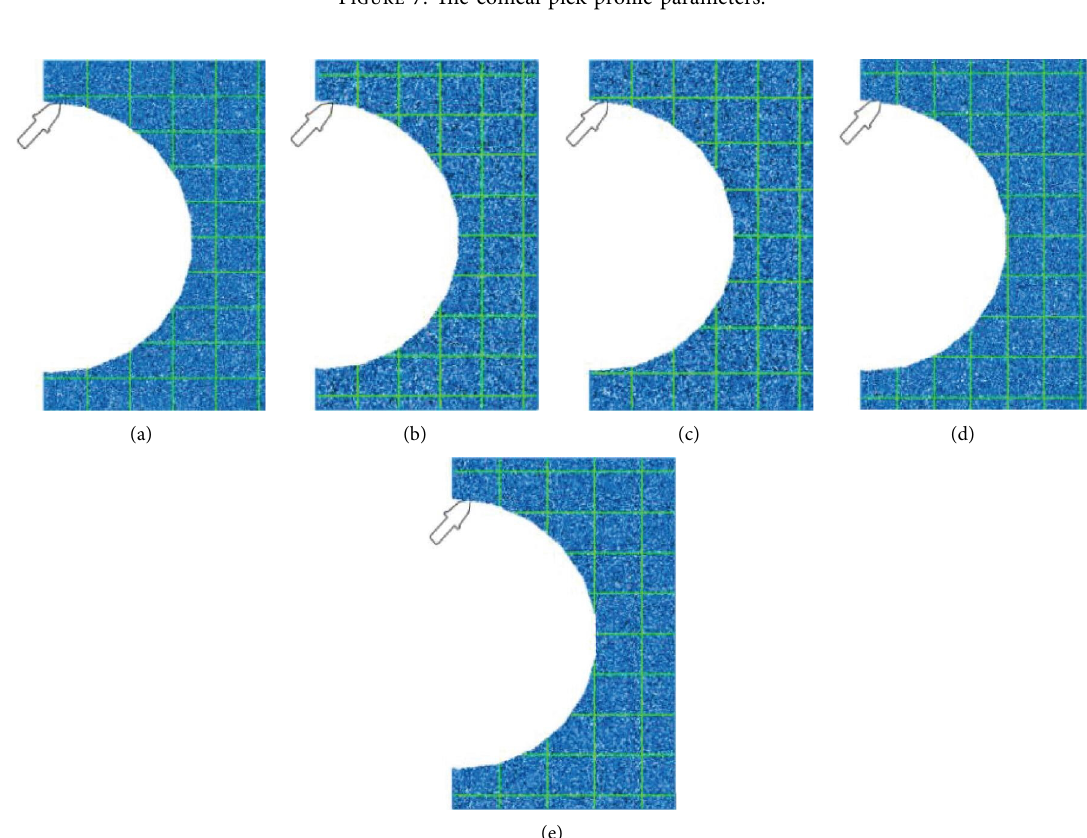
Figure 7: The conical pick profile parameters.